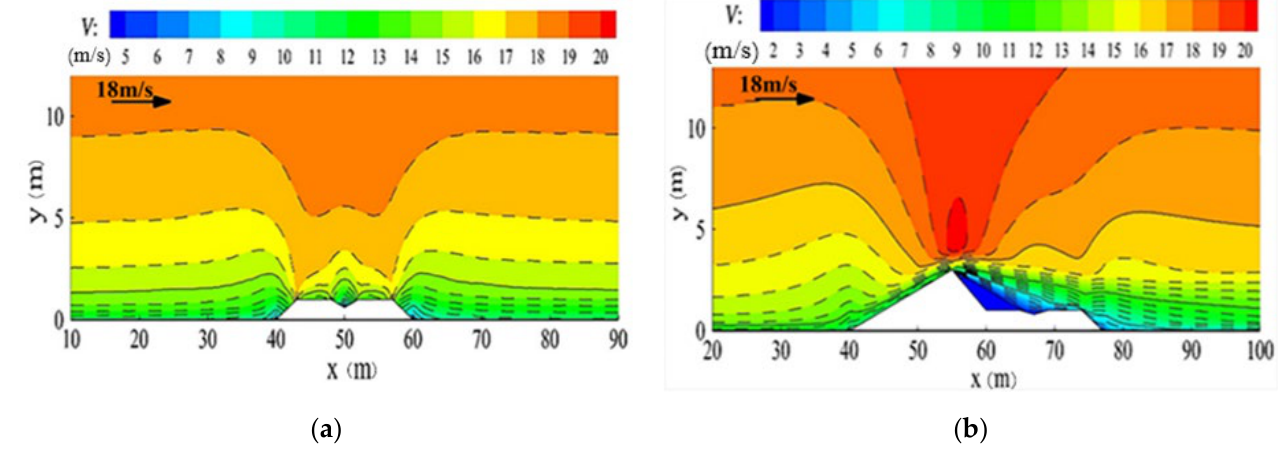
Figure 9. Distribution of wind-sand flow field around subgrade in flat terrain ( a ) and windward dune ( b ).